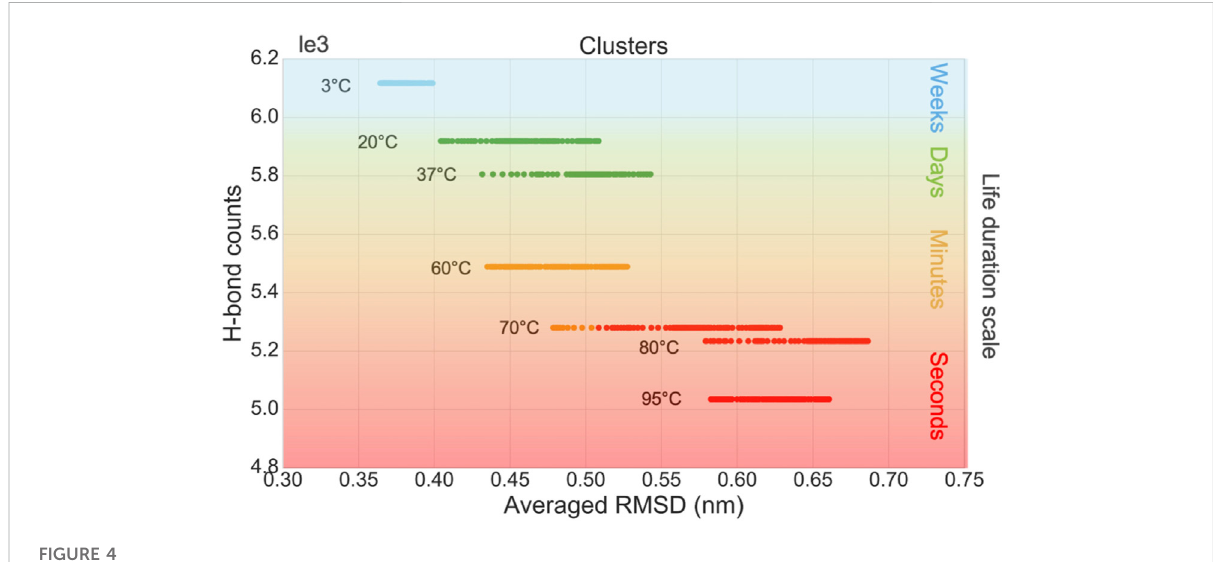
FIGURE 4 Clustering results of K-means using H-bond counts and average RMSD.